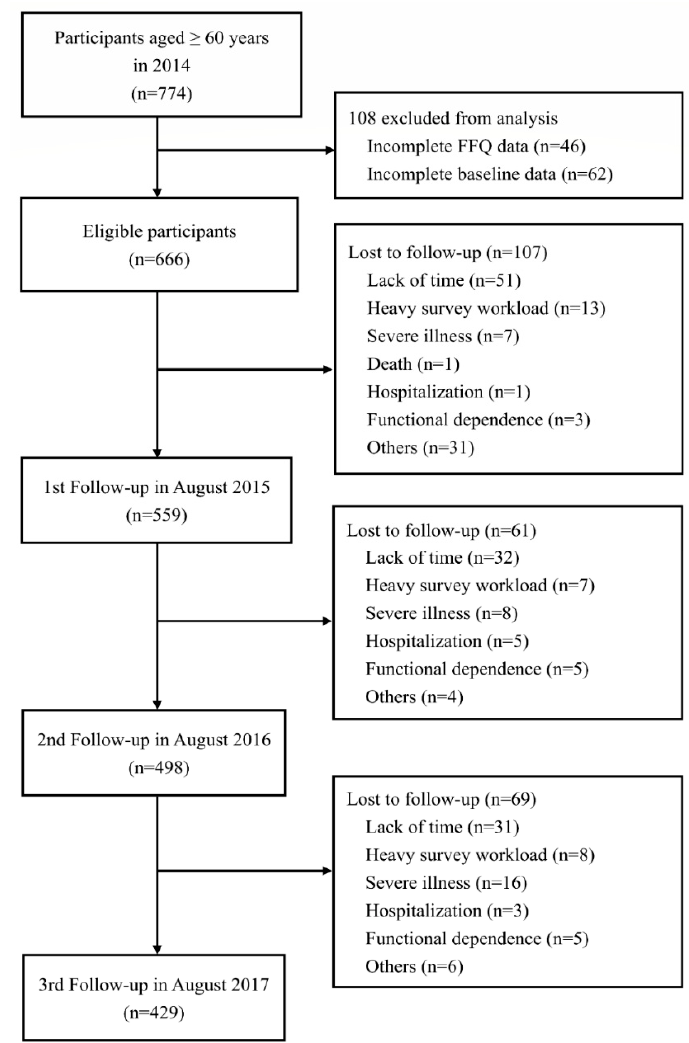
Figure 1. Flowchart of study participants and follow-up.